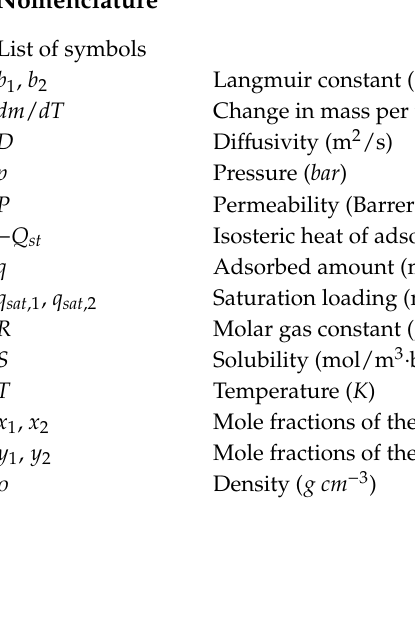
Figure S1: Characterization of nanocrystal HKUST-1, showing (a) X-ray di ff raction pattern, (b) N 2 physisorption isotherm at 77 K (open and closed symbols indicate adsorption and desorption branches, respectively), (c) FT-IR spectrum, as well as (d) TGA curve, showing weight loss and dm / dT against temperature, of nanocrystal HKUST-1 from 40 to 800 ◦ C. Figure S2: C 2 H 4 and C 2 H 6 adsorption of HKUST-1 at (a) 25 ◦ C and (b) 35 ◦ C, (c) − Q st of HKUST-1 for C 2 H 4 and C 2 H 6 . Figure S3: FT-IR spectrum of (a) ODPA-TMPDA and (b) 6FDA-TMPDA polymer. Figure S4: TGA analysis (a,b) weight loss against temperature and (c,d) dm / dT against temperature of 10